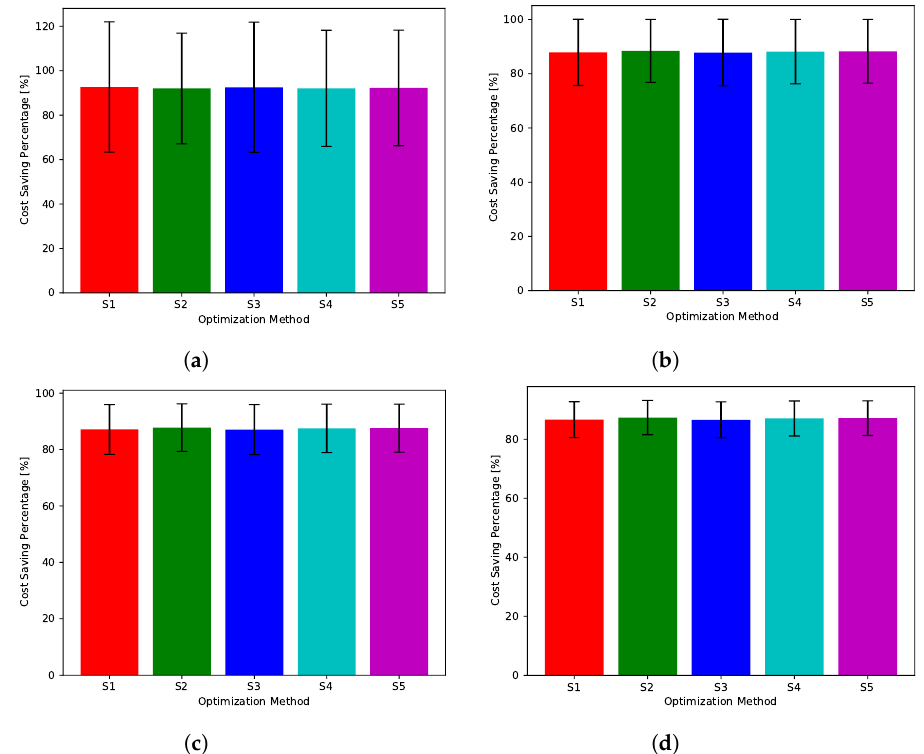
Figure 23. The total cost saving achieved by the proposed greedy scheduler when compared with scheduling policies fixed uncertainty level U 10 . ( a ) Monthly, ( b ) quarterly, ( c ) semiannually, and ( d )